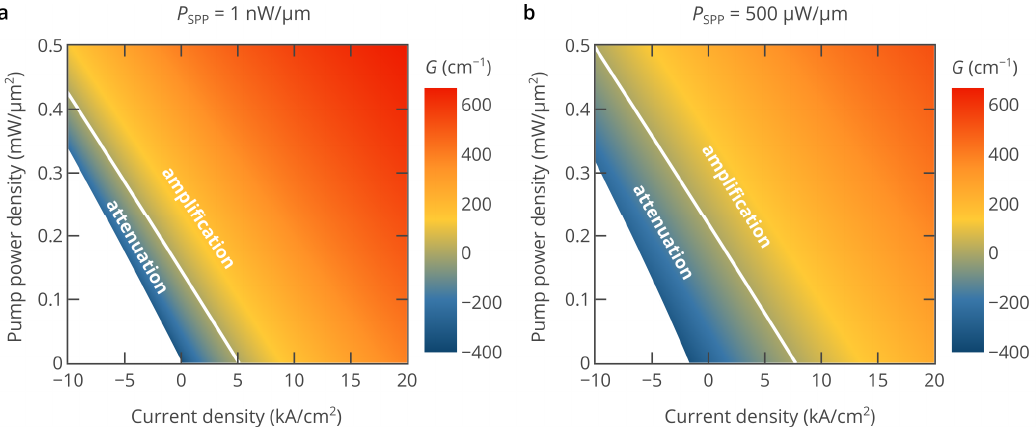
Figure 4. Heatmap of the SPP modal gain as a function of the pump current and optical pump power for a low-power signal ( P SPP = 1 nW / µ m) (panel ( a )) and a high-power signal ( P SPP = 500 µ W / µ m) (panel ( b )). In both panels, the white line corresponds to the regime of lossless SPP propagation, i.e., the net SPP modal gain is equal to zero, and the propagation losses are fully compensated by gain in InAs. The white area in the left bottom corner corresponds to negative bias voltages, which are out of practical interest for hybrid pumping.